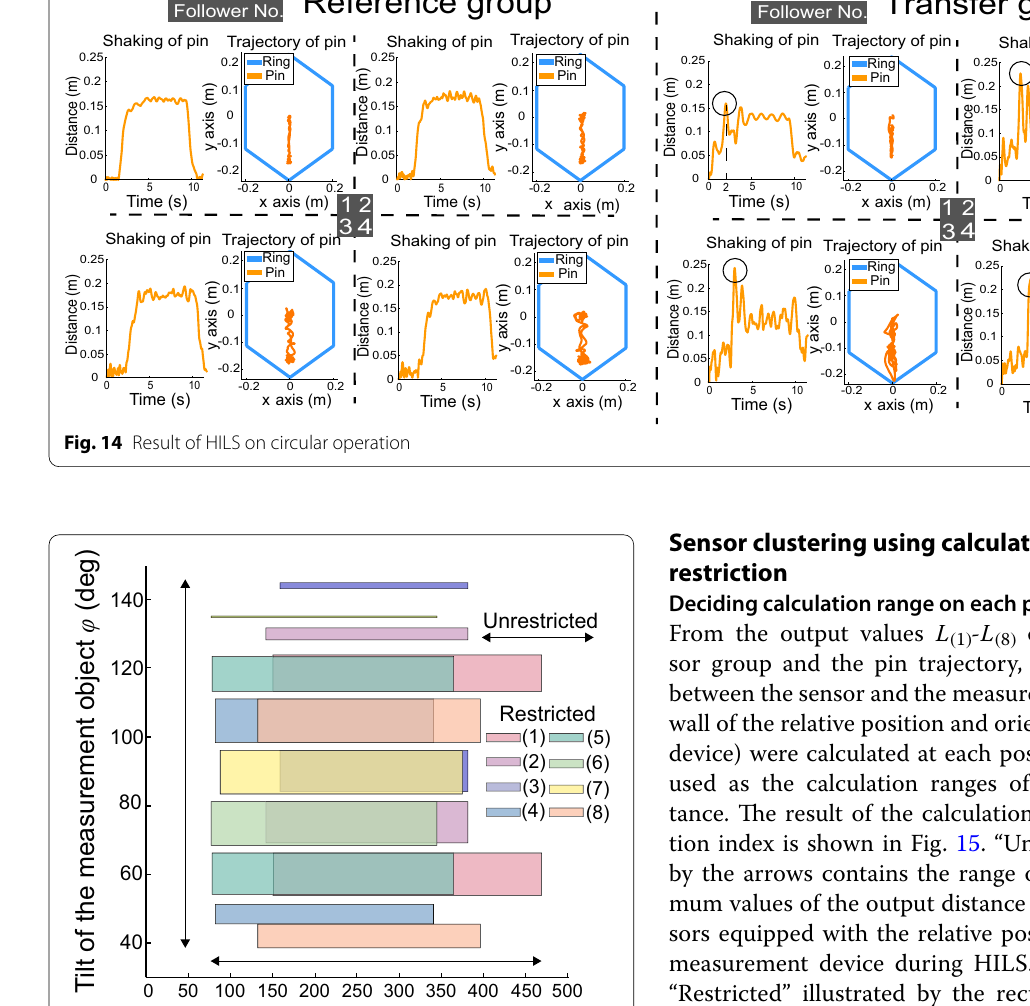
Distance to the measurement object d (mm) Fig. 15 Result of calculation range restriction for each However, it is important to select more similar sensors to further improve the accuracy of relative position and orientation measurements. As the range of distance d and tilt ϕ used to calculate the normalized distance may not be suitable for platooning, the calculation range of the normalized distance must be restricted to those used for platooning. Table 3 illustrates number of followers maintained in platooning by each group in the verification experiment.